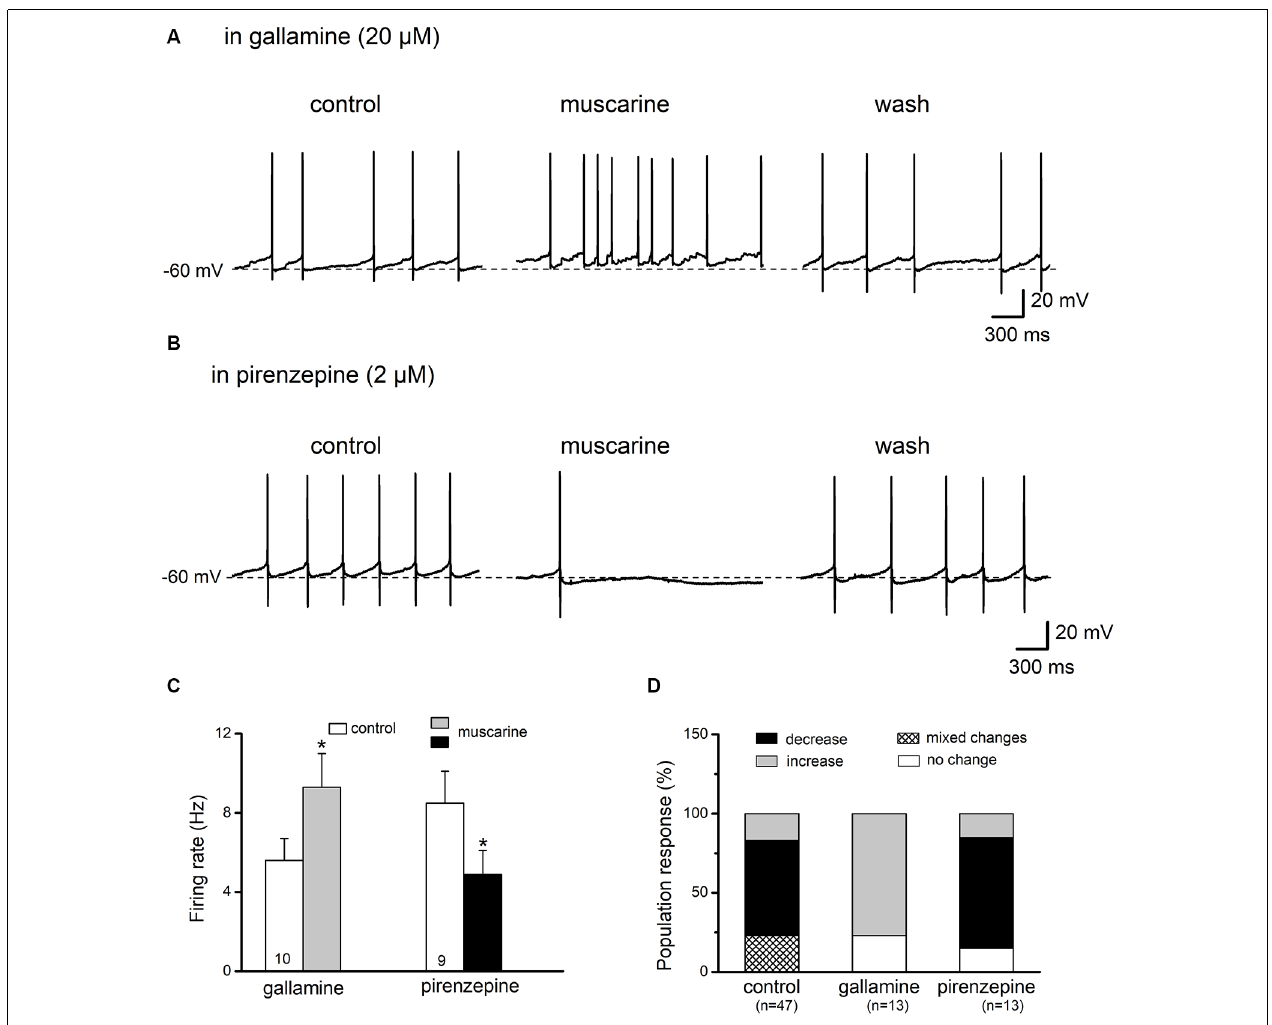
FIGURE 6 | Pharmacological profiles of muscarinic effects on preBötC glycinergic neurons. Panels (A,B) are illustrations of the effects of muscarine (10 µ M for 6–8 min) in the presence of the M 2 R antagonist gallamine (20 µ M) and of the M 1 R antagonist pirenzepine (2 µ M), respectively. Muscarine effects on firing were partially reversible (wash). The histogram in (C) summarizes responses to muscarine in control and in the presence of muscarinic receptor blockers. The histogram in (D) summarizes responses to muscarine. Mixed response patterns to muscarine were observed in the control group (with muscarine alone), with most neurons (28 out of 47 neurons or 60%) showing a reduction in firing rate. The majority of responses were shifted to an increase in firing rate in the presence of gallamine (10 out 13, or 77%) or a decrease in the presence of pirenzepine (9 out 13, or 70%). ∗ p < 0.05, compared to respective